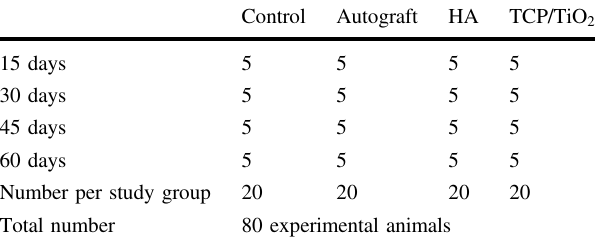
Table 1 Overview of the experimental animals per group and time point